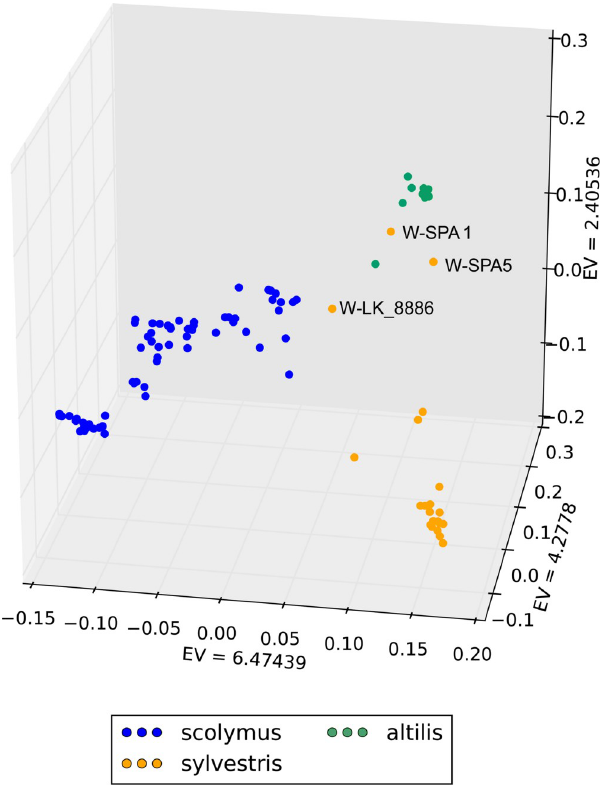
Fig 3. Graph of the first three axes from a Principal component analysis (PCA) of the 92 Cynara cardunculus genotypes analysed. EV: eigenvalue. Blue: globe artichoke; green: cultivated cardoon; orange: wild cardoon.